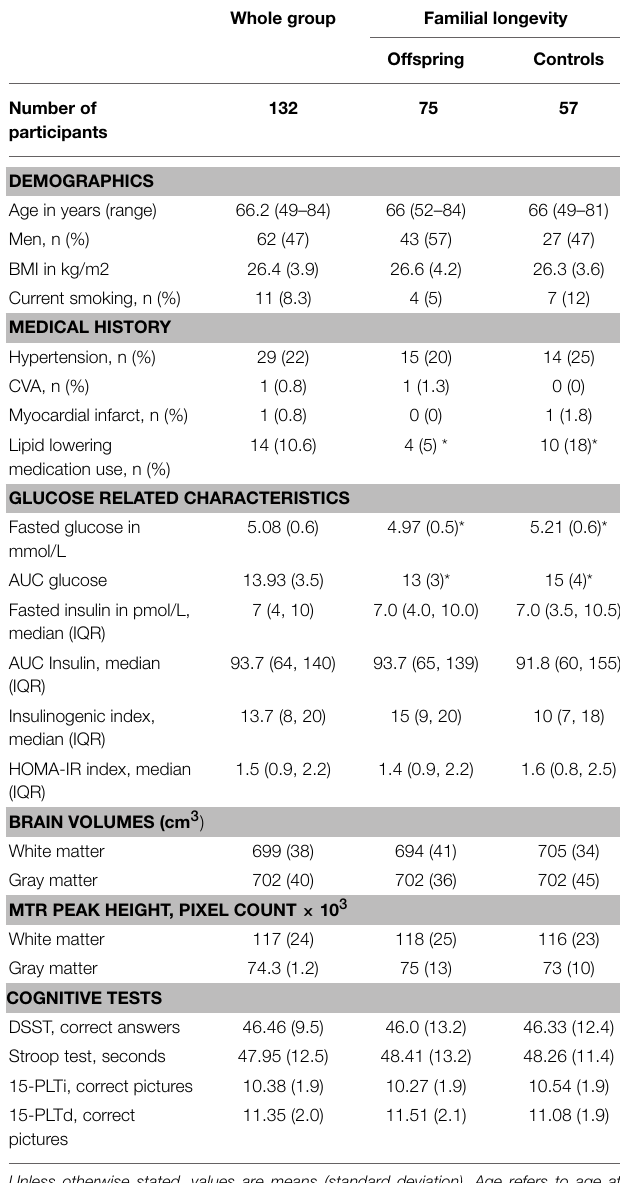
TABLE 1 | Characteristics of study